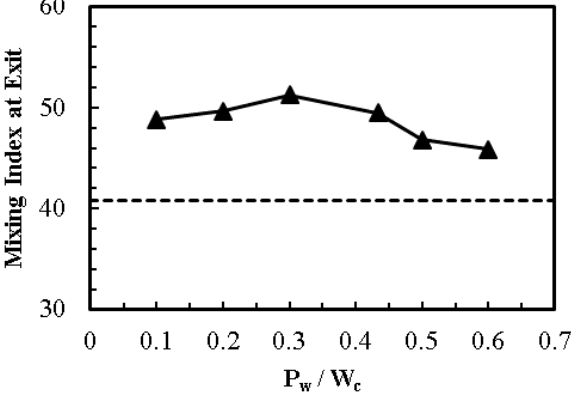
Figure 13. Effect of P w / W c on mixing index at the exit (homogeneous channel, dashed line; heterogeneous channel, solid line with symbols).